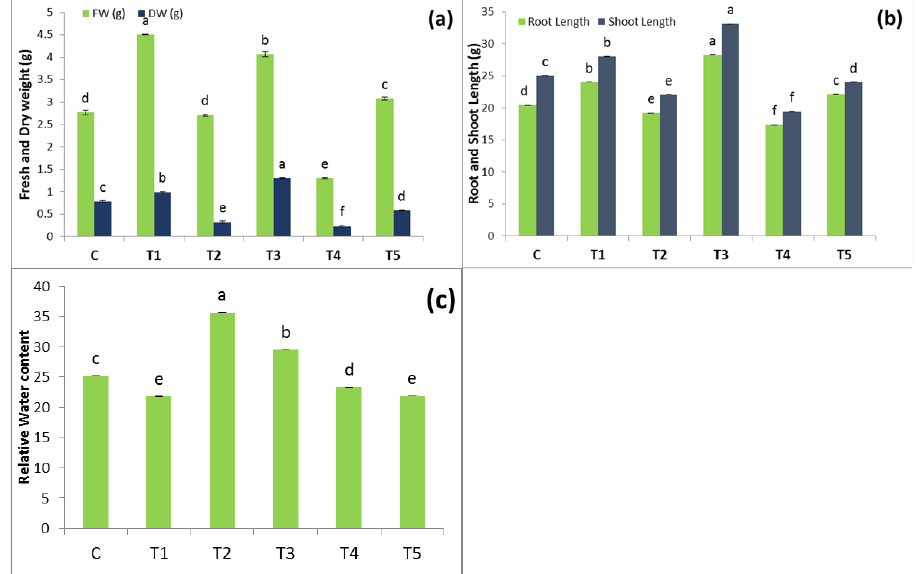
Figure 1. Fresh and dry biomass ( a ), root and shoot length ( b ), and relative water content ( c ) of A. rosea plants under Cd and citric acid application. The bars indicate mean values ± standard error. Where T1 = 5 mM · kg − 1 CA, T2 = 100 mg · kg − 1 Cd, T3 = 100 mg · kg − 1 + 5 mM · kg − 1 , T4 = 200 mg · kg − 1 Cd, and T5 = 200 mg · kg − 1 + 5 mM · kg − 1 . The different lowercase letter on the vertical bars represent significant differences among the treatments at p < 0.05.